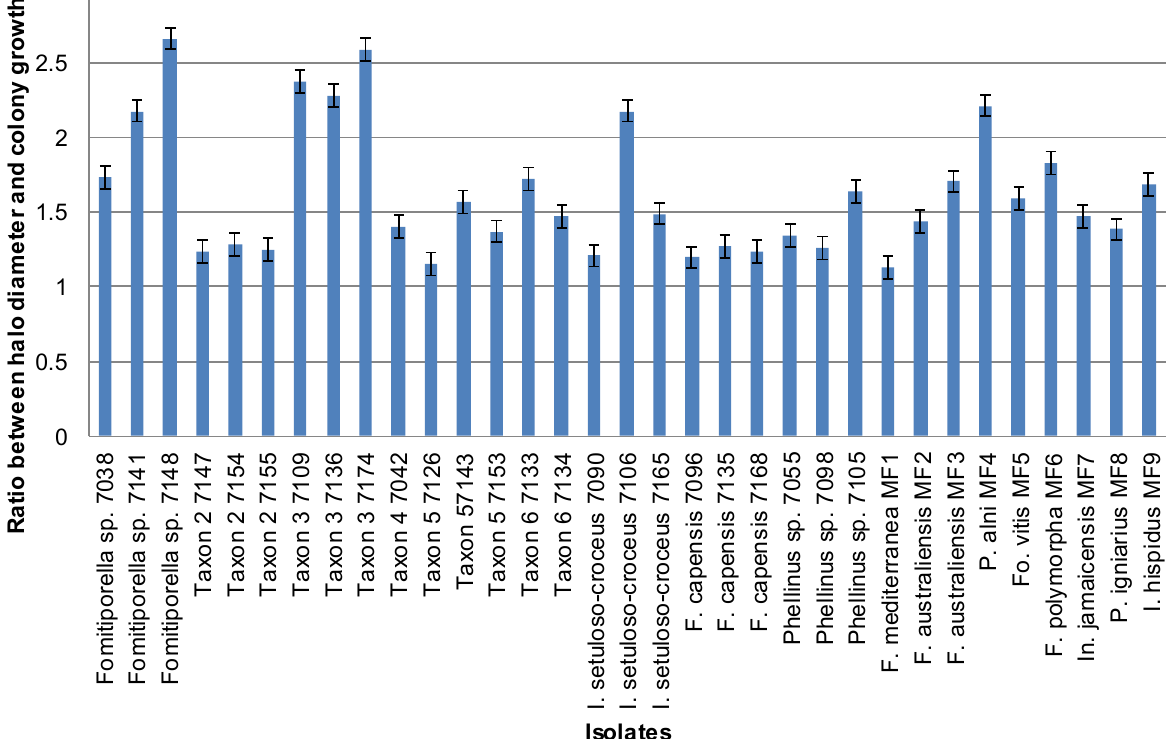
Figure 1. Ratio of halo diameter to colony growth obtained during the cellulase assays on the reference isolates and Hy - menochaetales isolates from White et al. (2011a). Bars represent the standard error of the mean between repeats